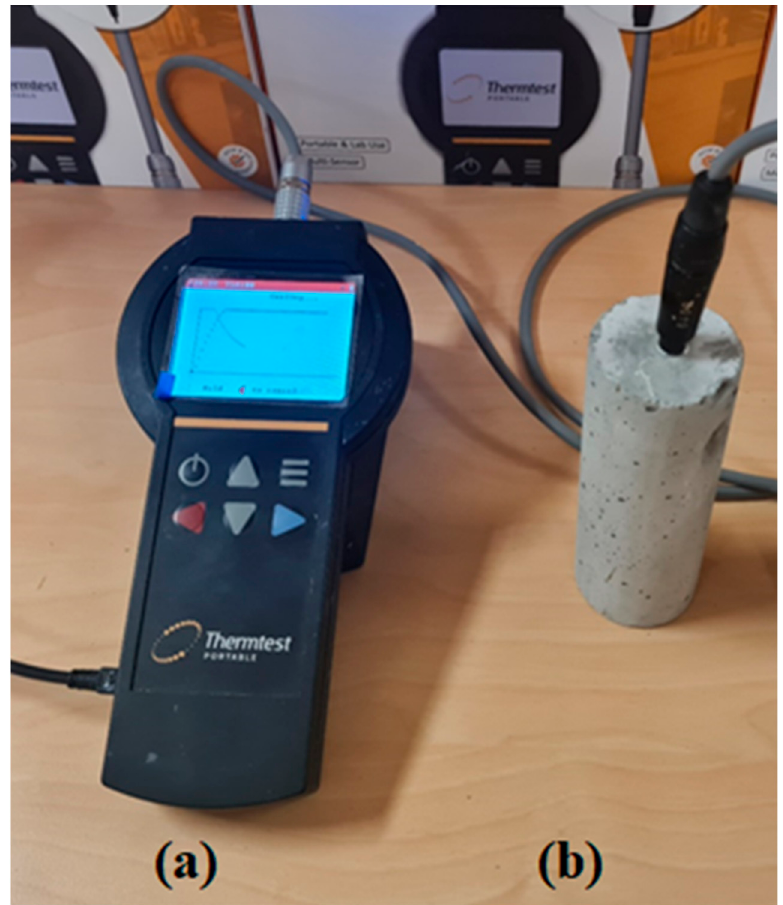
Figure 3. T hermal conductivity ( a ) datalogger and ( b ) TLS-100 sensor with test specimen. Figure 3. Thermal conductivity ( a ) datalogger and ( b ) TLS-100 sensor with test